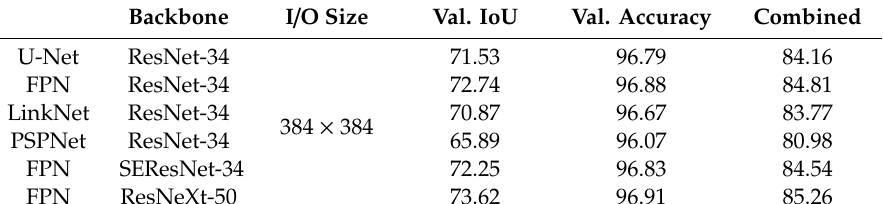
ISPRS Int. J. Geo-Inf. 2020 , 9 , x FOR PEER REVIEW